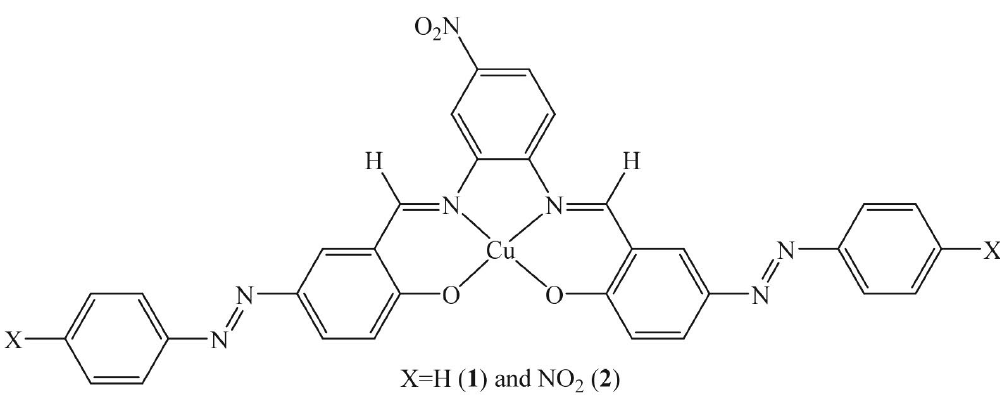
Fig. 9 . Job plots for ligand 1 with Cu 2+ (a) and Co 2+ (b) and ligand 2 with Cu 2+ (c) and Co 2+ (d), where the absorptions are plotted against the mole fractions of ligands at an invariant total concentration of 2 × 10 -5 M in